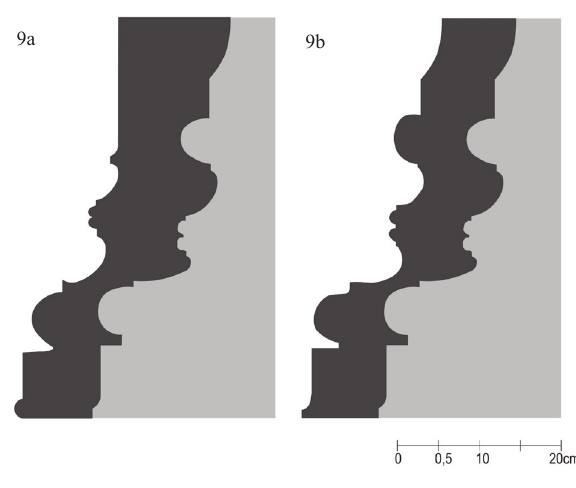
Figures 9a. Comparison between sections of mouldings of the right column and the left one Figure 9b. Comparison between sections of ancient and restoration mouldings (left